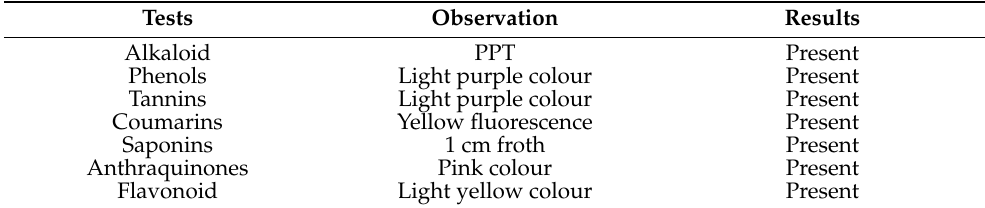
Table 1. Phytochemical investigation of P. rubra aqueous-methanolic leaf extract.